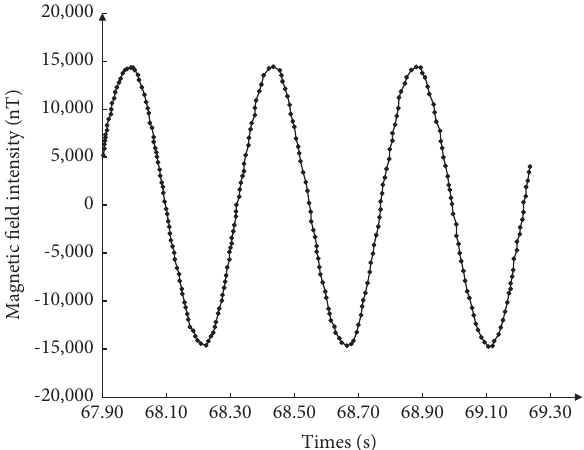
Figure 5: Data acquisition test result of three-axis DC